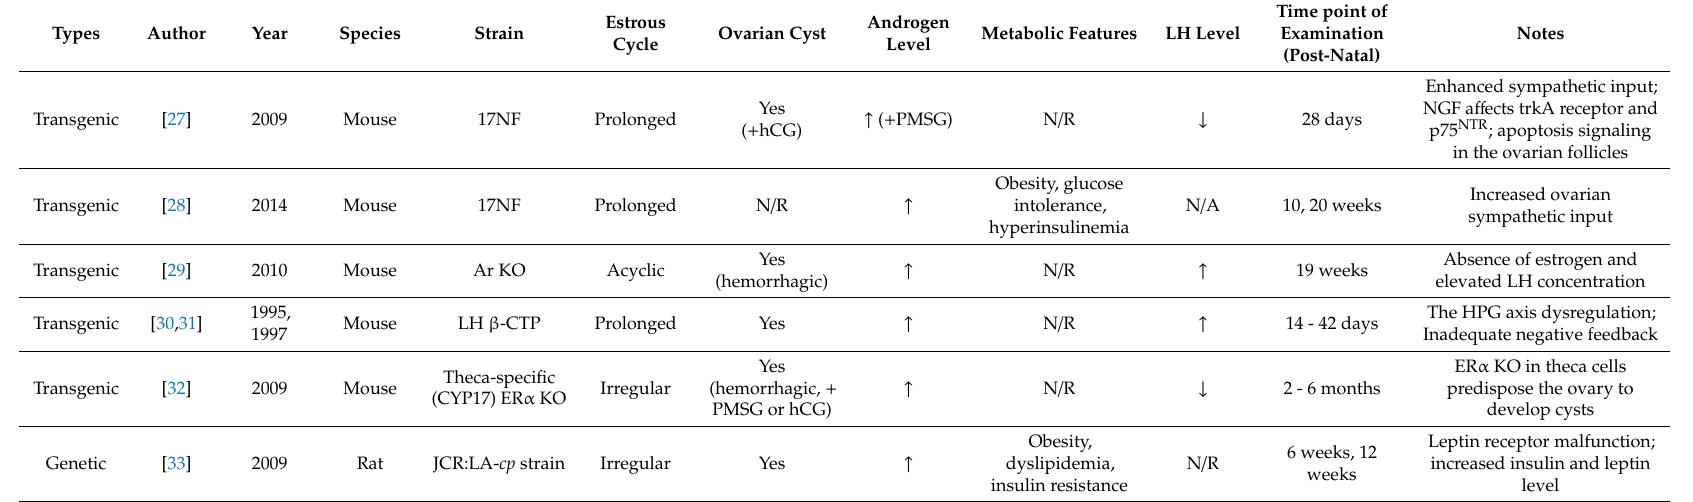
Table 1. Transgenic and genetically modified animal models including PCOS-like